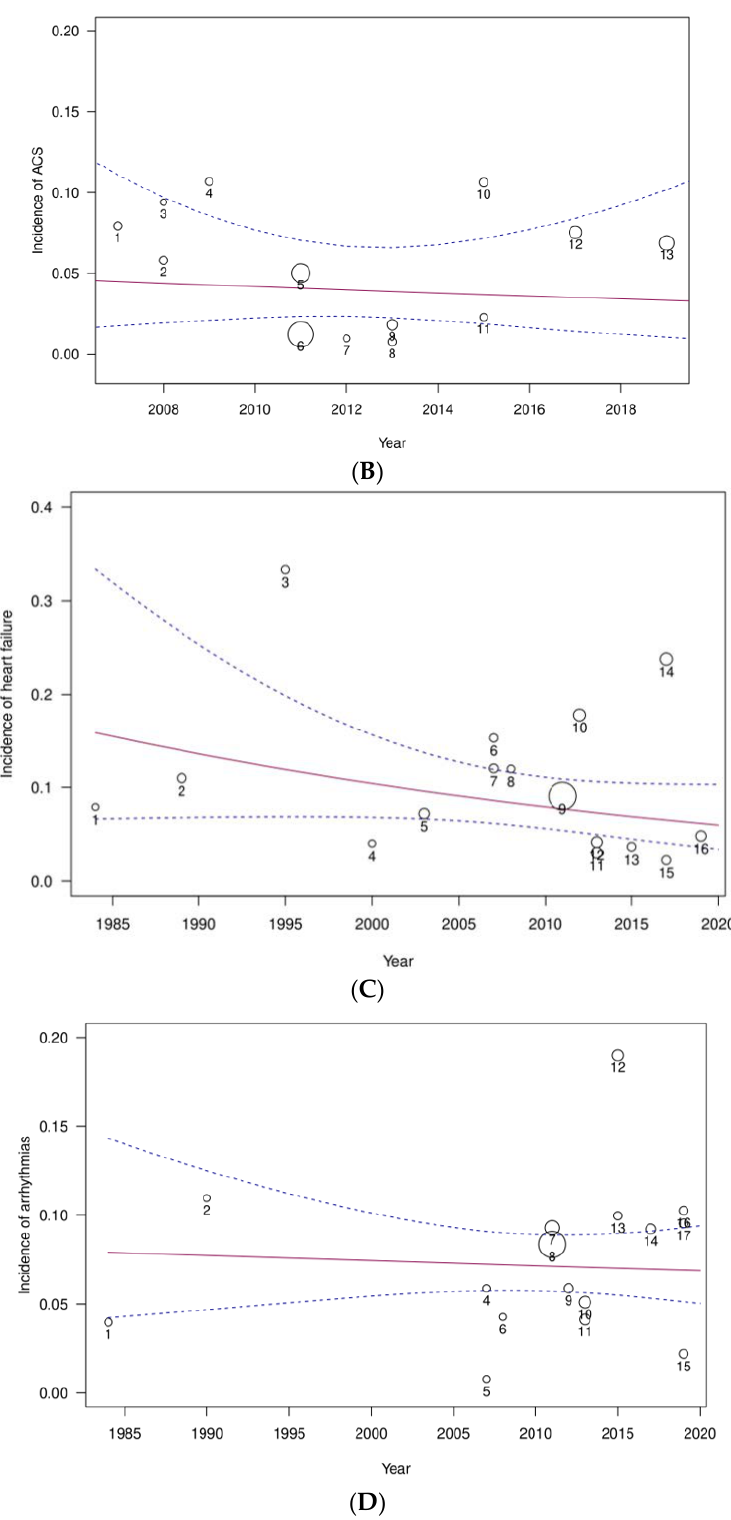
Figure 7. Meta-regression for ( A ) overall cardiac complications, ( B ) acute coronary syndromes ACS, ( C ) heart failure and ( D ) arrhythmias after community-acquired pneumonia, moderated by study year. Circle size is proportional to study sample size.